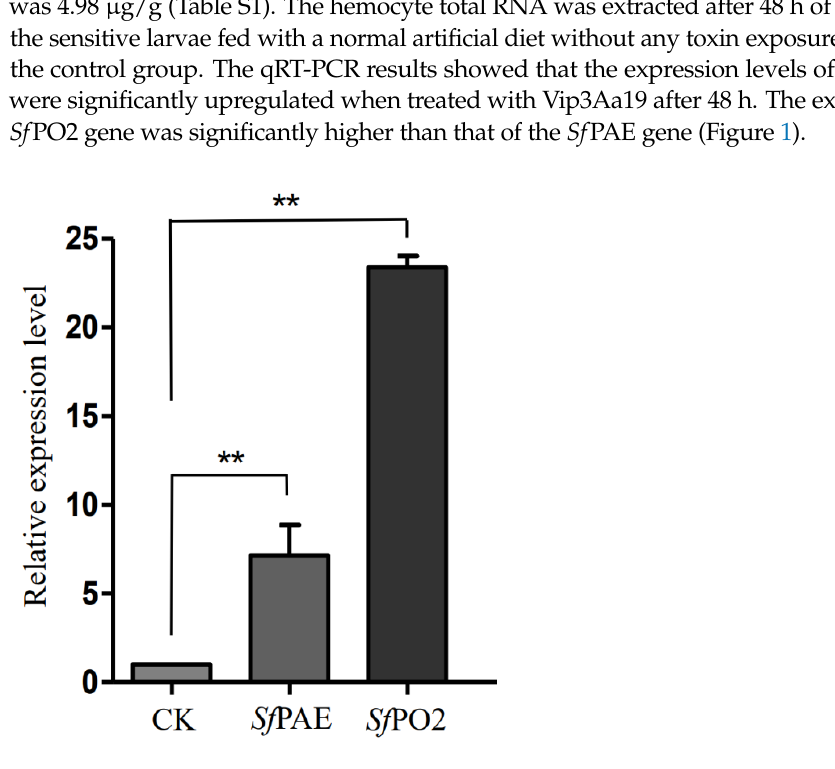
Figure 1. qRT-PCR measurement of Sf PAE and Sf PO2 mRNA expression levels treated with Vip3Aa19 toxin of S. frugiperda . CK: control group. Vertical bars under the asterisk indicate significant differences based on Tukey’s test (** p- value < 0.01).